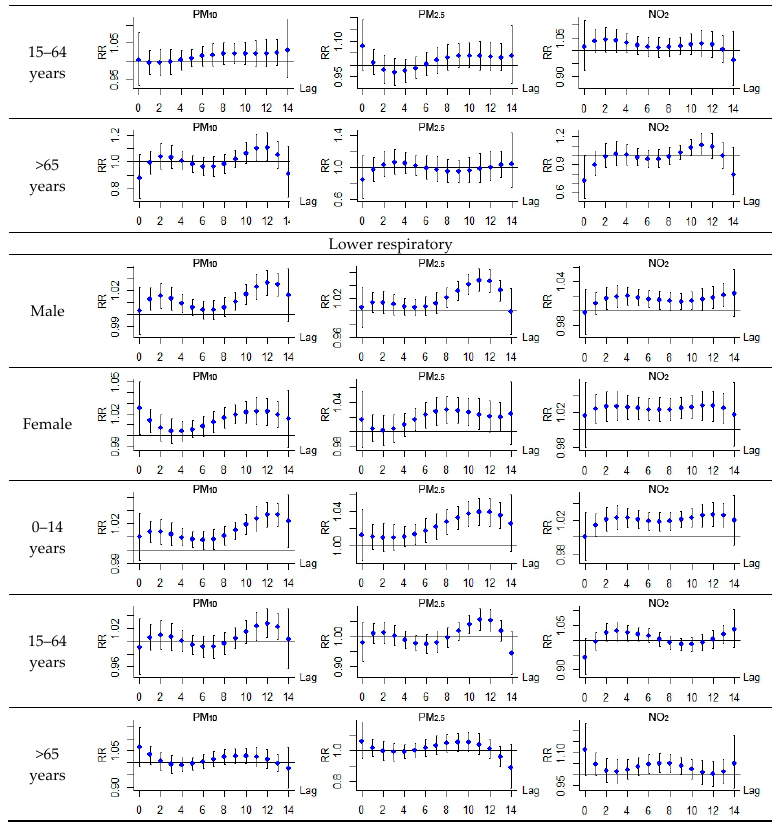
Figure 5. Lag–response relationship between air pollutants and the RR for acute respiratory infection in different population groups. Table 6. Percentage increase of hospital admissions in associations with 10 μ g/m 3 increase in air pollutant concentrations for different population groups in Shenzhen in 2013.